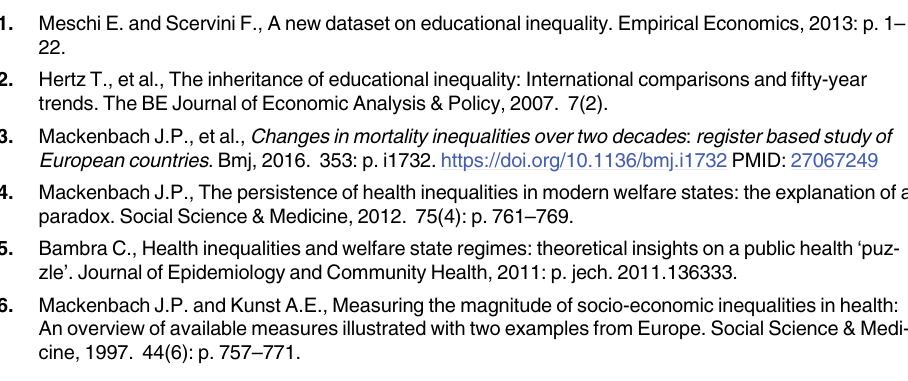
S2 Table. The association between individual education and proportion of high and low educated on all-cause mortality for men and women, 30–84 yrs. Adjusted for occupational